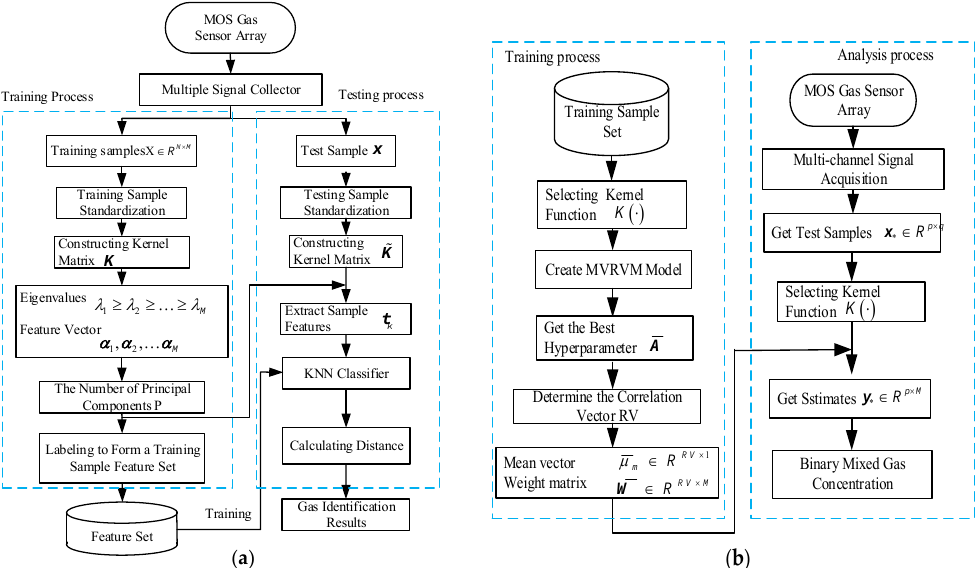
Figure 2. ( a ) Flow chart of binary mixed gas identification method based on KPCA and KNN; ( b ) flow chart of binary mixed gas concentration estimation method based on MVRVM.